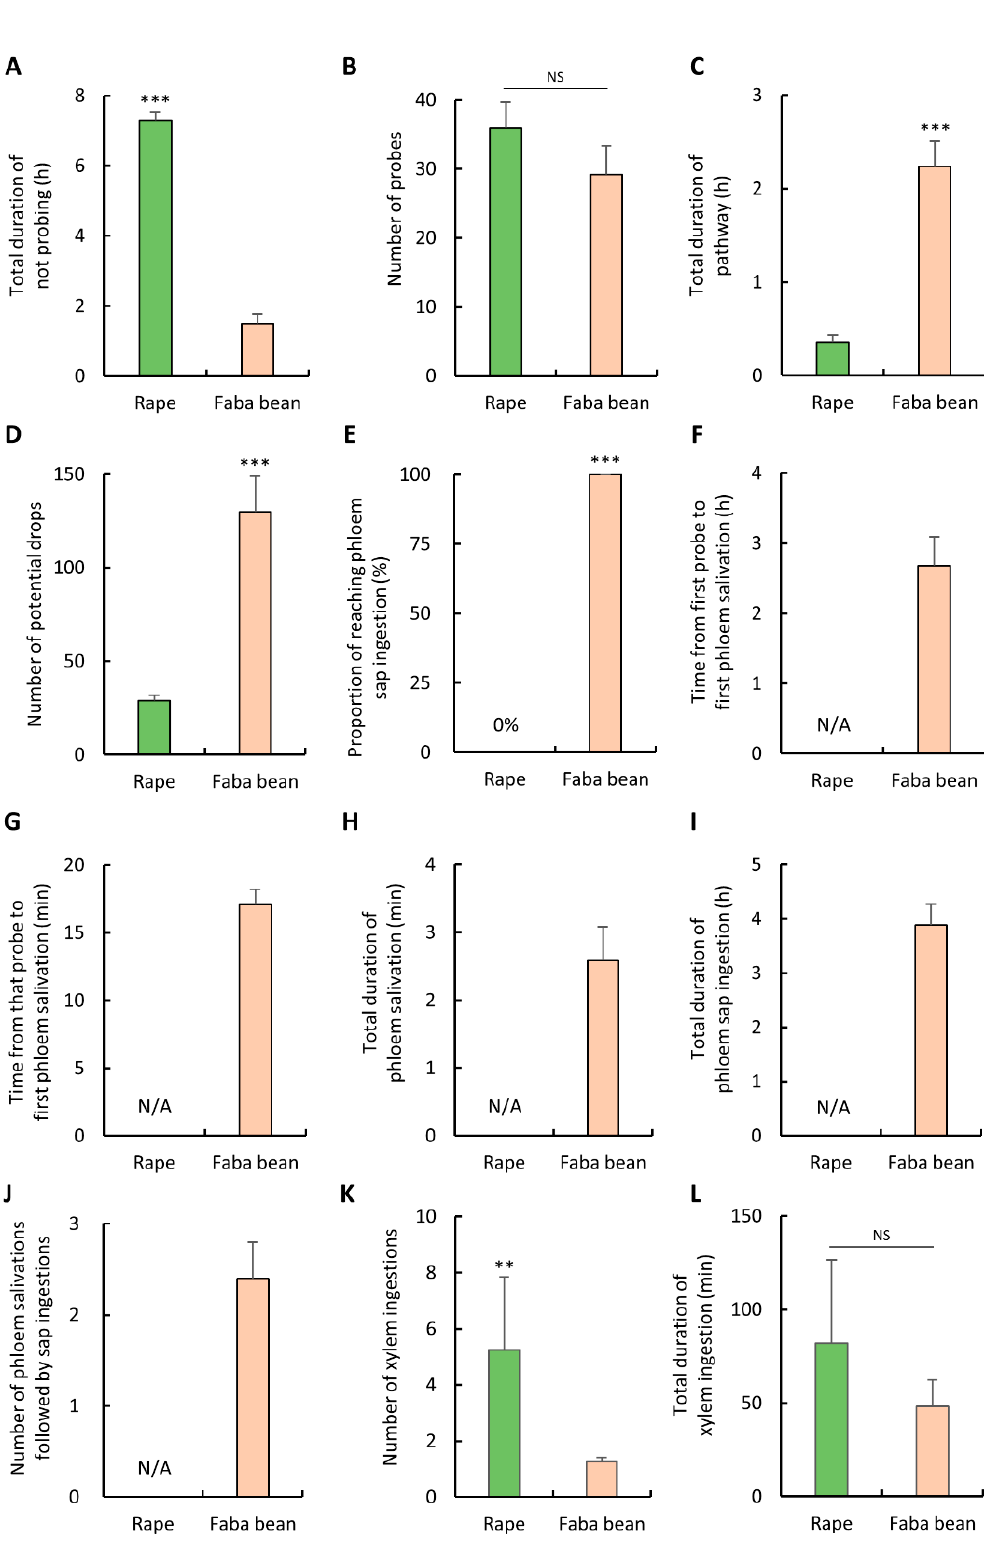
Figure 4. Waveform events and waveform duration of the ( A – D ) non-phloem parameters, ( E – J ) phloem-related parameters, and ( K , L ) xylem-related parameters of A. pisum on rape and faba bean. Error bars represent the standard errors of the means. Asterisks indicate significant differences between aphids probing on rape and faba bean (** p < 0.01; *** p < 0.001). NS indicates non ‐ significant difference ( p > 0.05).